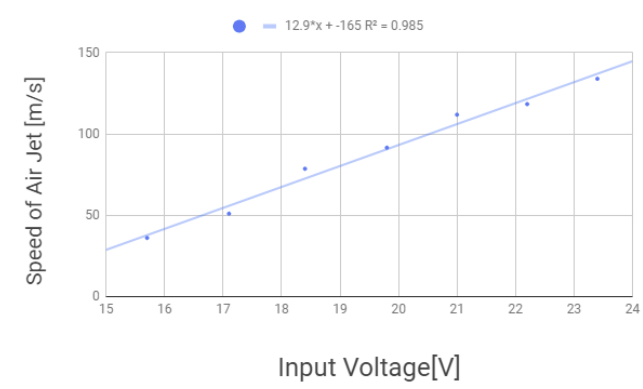
Figure 6. Velocity control of the airflow from the air control value.